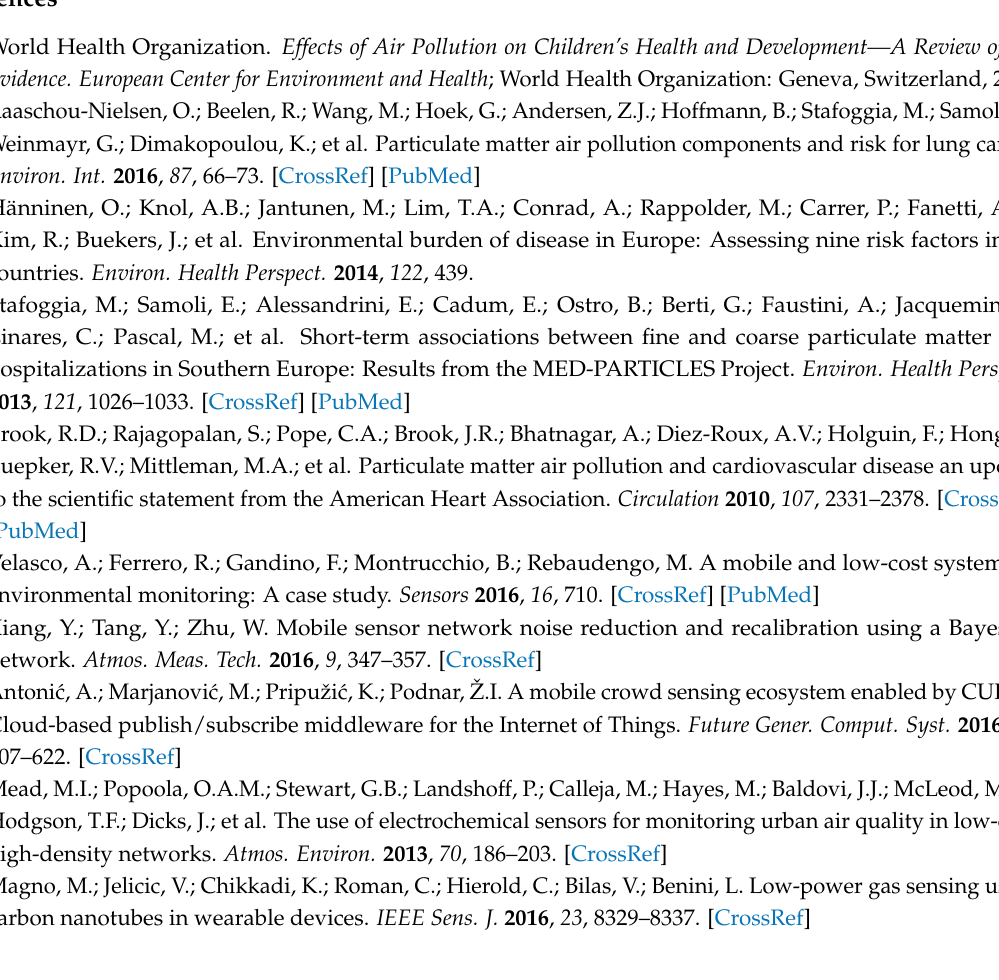
Regression parameters were calculated and reported for the summer and winter datasets. Figure S5: Bland-Altman plot. Red dotted lines represent upper and lower confidence intervals (95%) while the green dotted line represents the average difference between instruments. The mean concentrations between EPA WINS and the compared instruments (a.: AB1; b.: AB2; c.: AB3) are reported on the x-axis while the differences between the methods are shown (8-h average) on the y-axis. Table S8: Relative error (%) calculated during all monitoring sessions between direct-reading instruments and the gravimetric method. Table S9 Absolute error ( µ g/m 3 ) calculated during all monitoring sessions between direct-reading instruments and the gravimetric method. Figure S6: Analysis of absolute error (absolute value - µ g/m 3 ) for ABs as a function of PM 2.5 concentrations ( µ g/m 3 ) and RH (%). Figure S7: Analysis of relative error (absolute value - %) for ABs as a function of PM 2.5 concentrations ( µ g/m 3 ) and RH (%). Figure S8: Analysis of absolute error (absolute value - µ g/m 3 ) for direct-reading instruments as a function of PM 2.5 concentrations ( µ g/m 3 ) and RH (%). Figure S9: Analysis of relative error (absolute value - %) for direct-reading instruments as a function of PM 2.5 concentrations ( µ g/m 3 ) and RH (%). Figure S10 Analysis of relative error (%) for direct-reading instruments as a function of PM 2.5 concentrations ( µ g/m 3 ) and RH (%). a.: AB1; b.: AB2; c.: